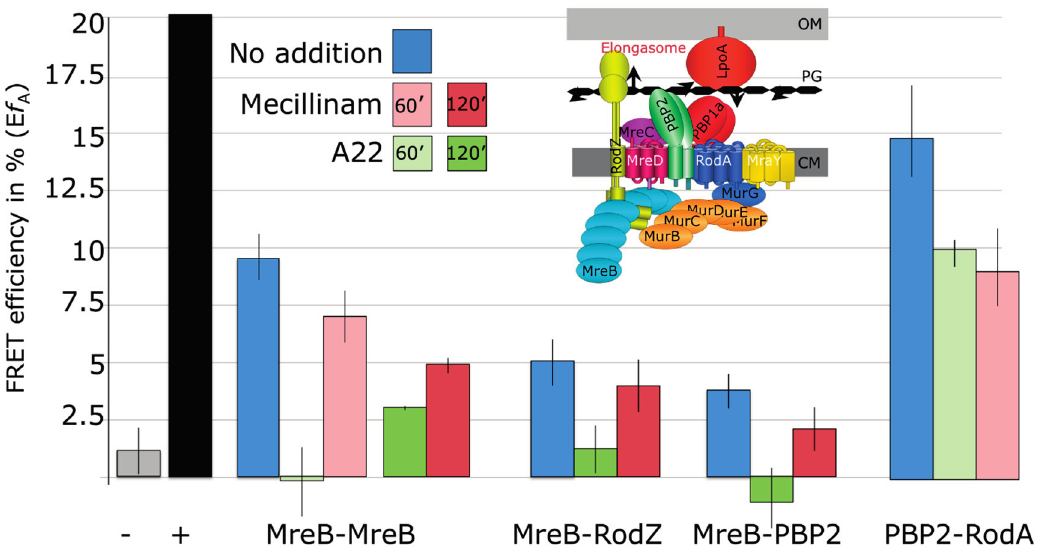
Figure 4. Interactions within the elongasome are affected by the MreB inhibitor A22 and by the PBP2 inhibitor mecillinam. MC4100 cells transformed with two plasmids that expressed the SYFP2 donor and the mCherry acceptor, respectively, fused to the indicated elongasome proteins were grown to steady state at 28 °C. At an optical density at 450 nm of 0.2 the cells were fixed and washed as described in the materials and methods and concentrated to an OD 450 of 1.0. Spectra excited at 587 and 590 nm were collected and unmixed in contribution of the background, SYFP2 donor, direct excitation of the mCherry acceptor and the mCherry sensitized emission (Figure 1). Sensitized emission was used to calculate the apparent efficiency of energy transfer Ef A plotted on the vertical axes (with the standard error of the mean). Blue is the FRET efficiency in the absence of inhibitors, green in the presence of A22 for 60 min (light green) or for 120 min (dark green) and red in the presence of mecillinam for 60 min (light red) or for 120 min (dark red). The black bar shows the FRET efficiency of a direct fusion between SYFP2 and mCherry as a positive control and the grey bar shows the FRET efficiency between fusions to PBP3 and PBP1A that do not interact (see Table S2 for the exact data and the number of independent repeats for each sample and the supplementary dataset for all unmixed spectra).